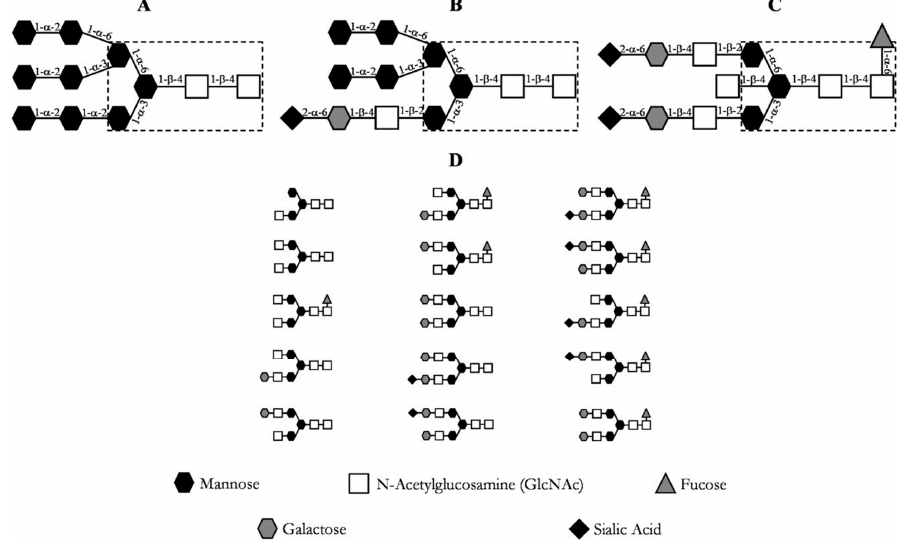
3 Figure 3. Common glycosylation patterns of an IgG. ( A ) high mannose content; ( B ) hybrid; ( C ) complex biantennary oligosaccharide with core fucosylation; ( D ) most prevalent oligosaccharide structures of IgG [20].